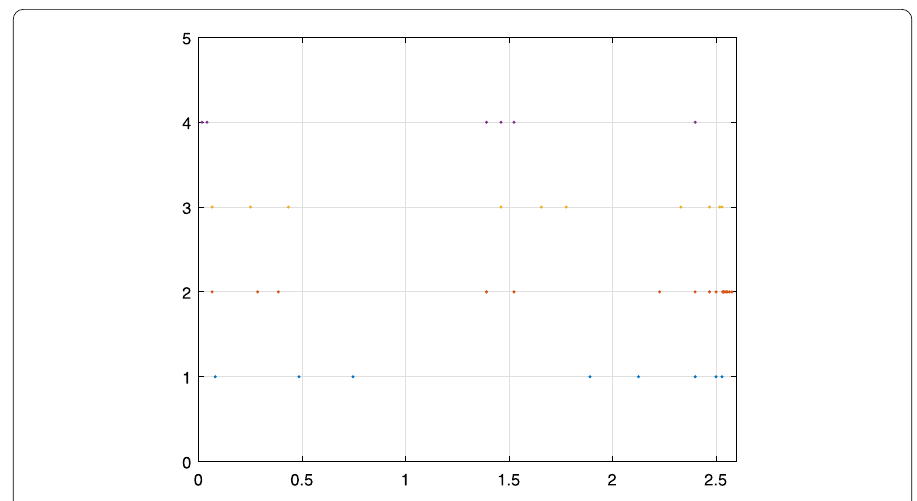
Figure 3 Instants when a control update is triggered during the time interval [0, 2.6]. The vertical positions of the markers indicate which node updates its control signal